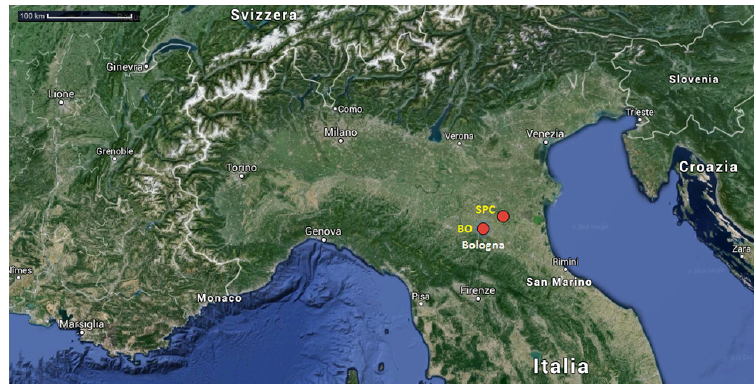
Figure 1. Location of the sampling sites in the Po